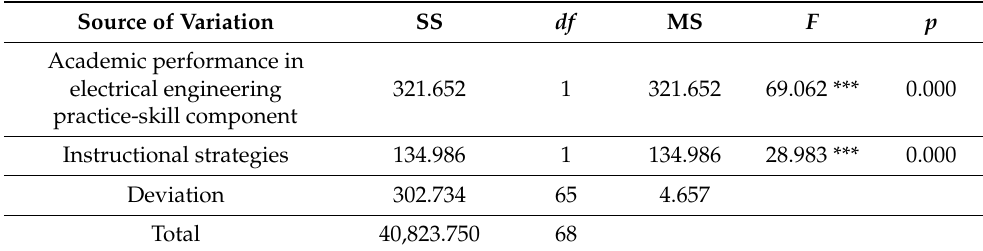
Table 16. Recapitulation sheet of analysis of covariance in basic electricity practical overall learning effectiveness in terms of the skill component.